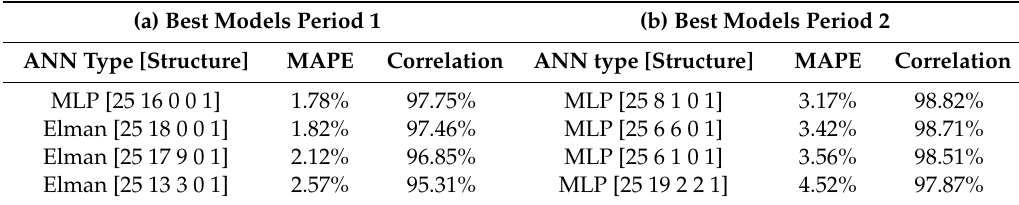
Table 2. Summary of the best ANN models for each period. The first digit in the ANN is the number of input variables, the next three digits are the hidden layers structure, and the last digit is the number of output variables.